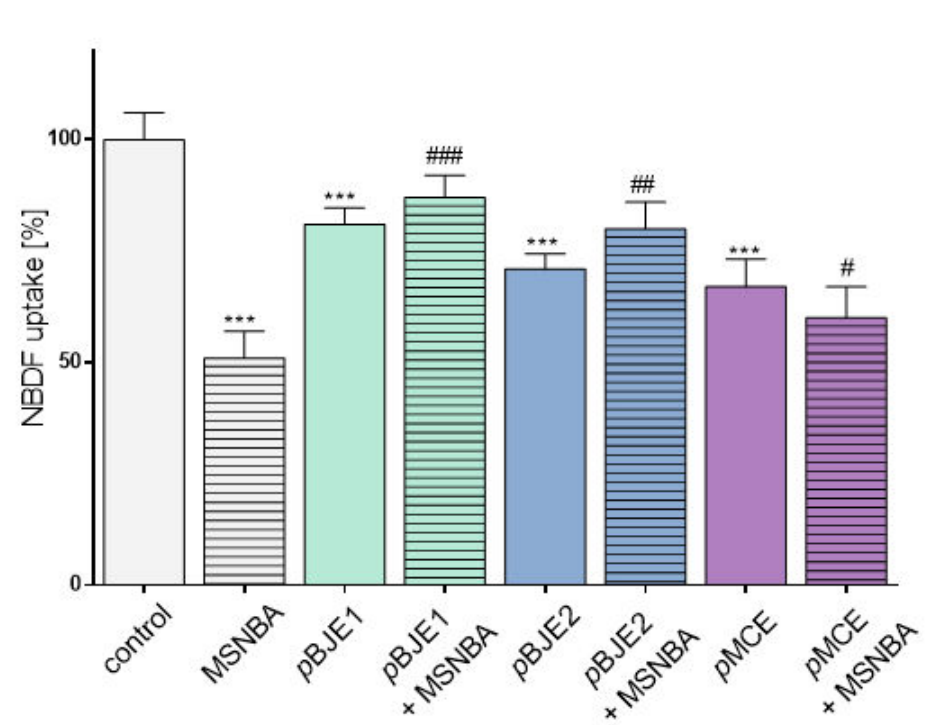
Figure 6. The effect of the purified extracts of Brassica juncea 1/2 (pBJE1/2) and Matricaria chamomilla (pMCE) used at 0.25 mg/mL concentration on NBD-fructose (100 µ M) uptake by Caco-2 cells after 24-h exposure; as GLUT5 inhibitor 50 µ M MSNBA was used (as a single compound or simultaneously with the preparations); control cells were not exposed to any compound except vehicle; values are means ± standard deviations from at least three independent experiments, n ≥ 9; statistical significance was calculated versus control cells (untreated) with *** p ≤ 0.001; statistical significance calculated versus cells treated with MSNBA with # p ≤ 0.05, ## p ≤ 0.01, ### p ≤